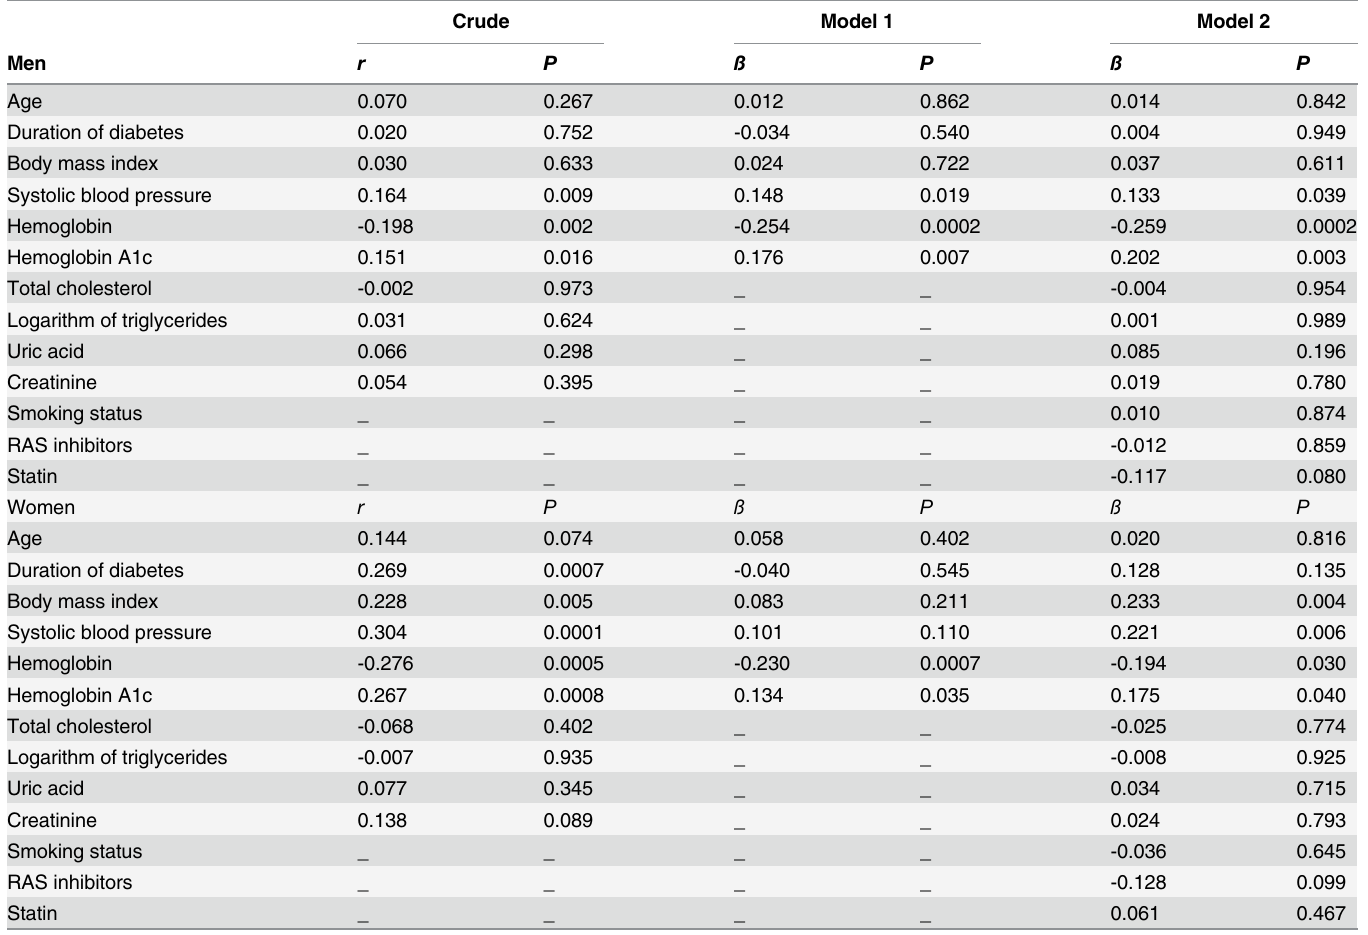
Table 3. Simple correlation and multivariate regression analyses on change in urinary albumin-creatinine